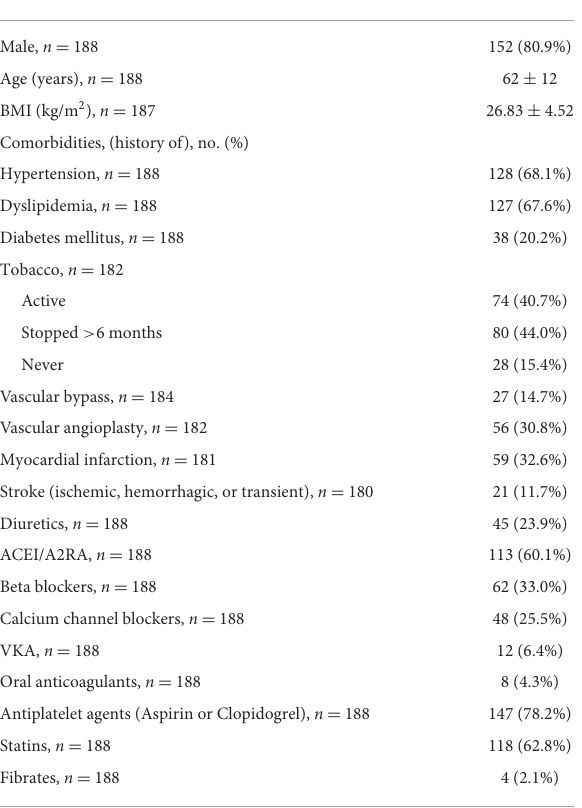
TABLE 2 Characteristics of the study